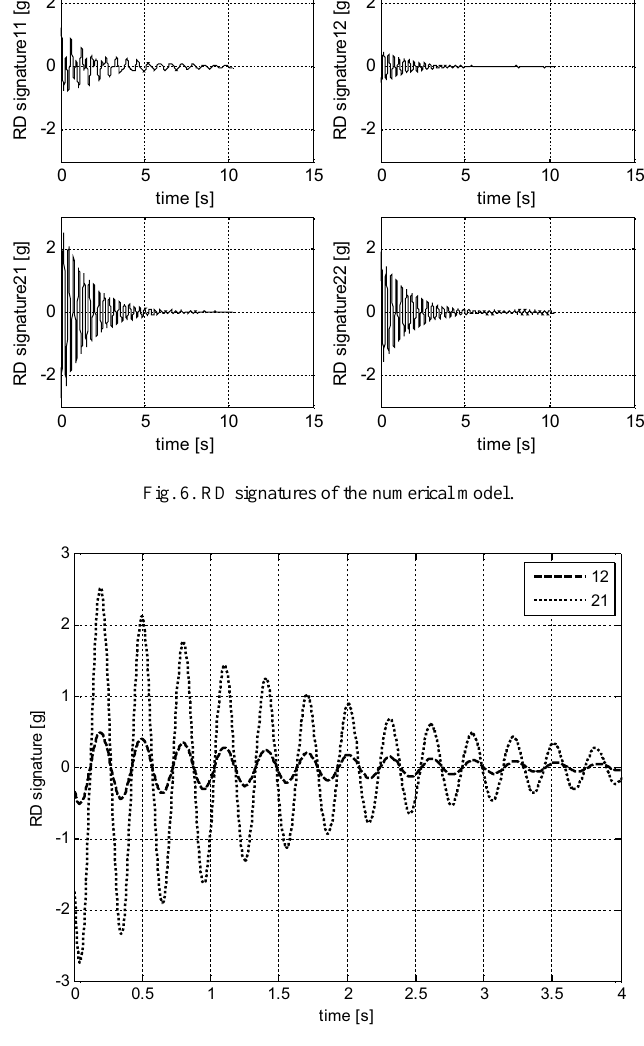
Fig. 7. Comparison of RD signatures 12 and 21 of numerical